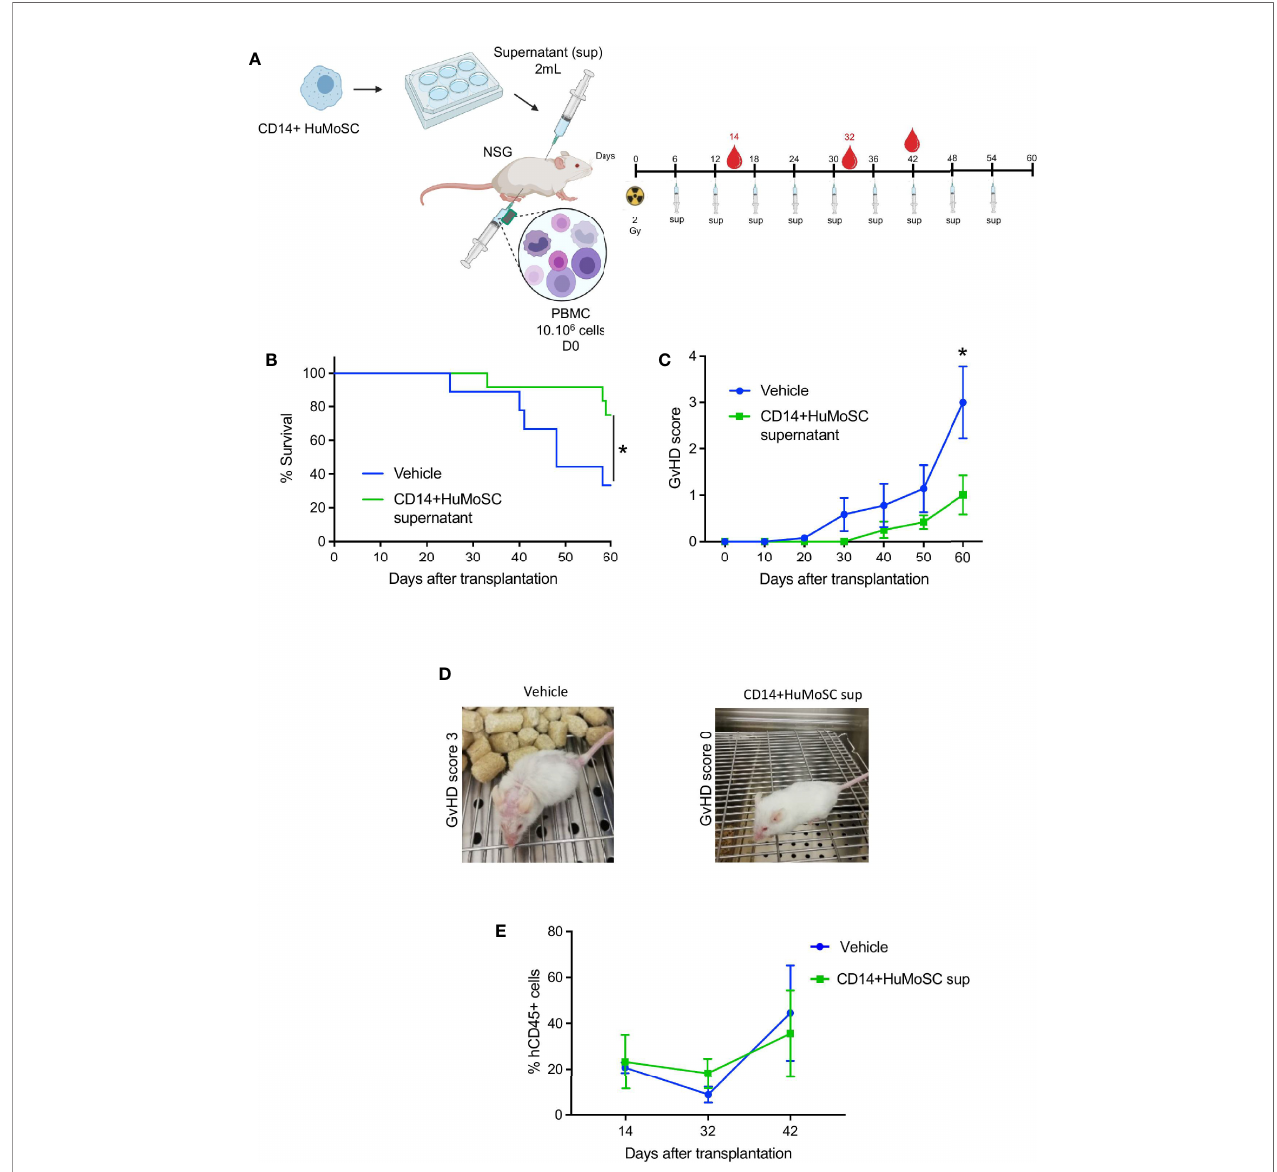
FIGURE 5 | CD14+HuMoSC supernatant mitigated xenoGvHD in NSG mice. (A) Schematic representation of xenoGVHD model and treatments. NSG mice aged 8- 12 weeks were irradiated (2 Gy) and received 10.106 huPBMC intraperitoneously and were then treated with 2 mL of physiological saline (vehicle, control group) or 2 mL of CD14+HuMoSC supernatant (CD14+HuMoSC supernatant group) once a week. At the indicated time, blood was harvested and human chimerism was evaluated by fl ow cytometry. (B) Survival curves were compared by using log-rank test. *p ≤ 0.05. (C) The GvHD score of the 2 groups was assessed twice a week. Two-tailed Mann Whitney test *p ≤ 0.05. (D) Photograph of two representative mice at day 60, a mouse treated with vehicle had a GvHD score of 3, a mouse treated with CD14+HuMoSC supernatant had a score of 0. (E) Human engraftment was evaluated at the indicated times using anti-human CD45 and anti-mouse CD45 antibodies. Results of 2 independent experiments and 9 mice per group are